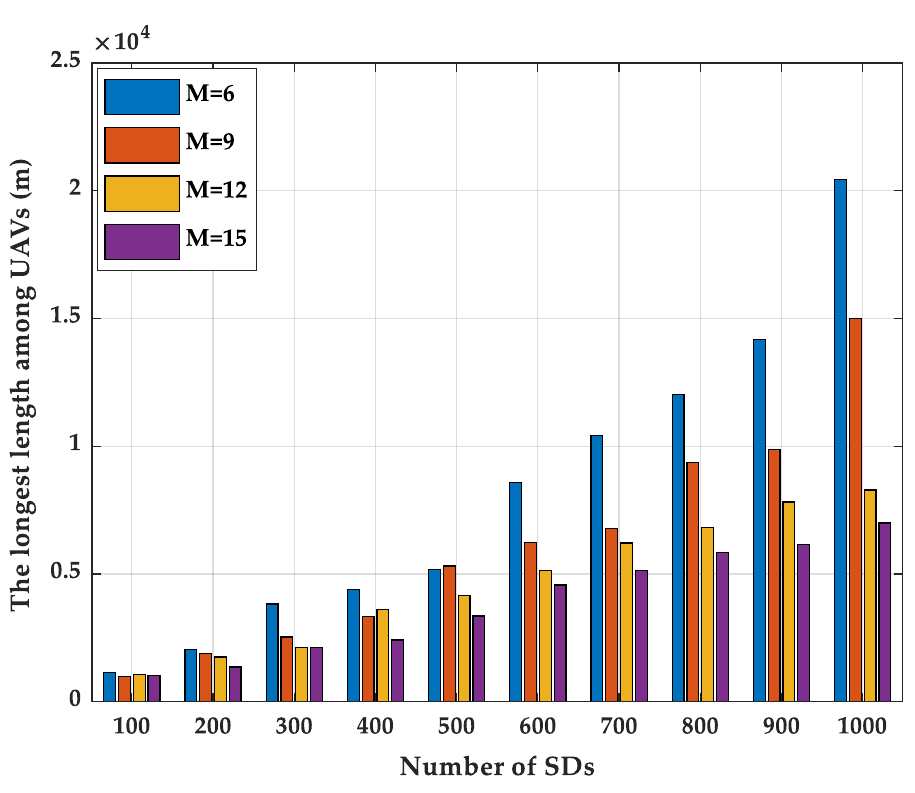
Figure 5. The longest trajectory of 6, 9, 12, and 15 UAVs.